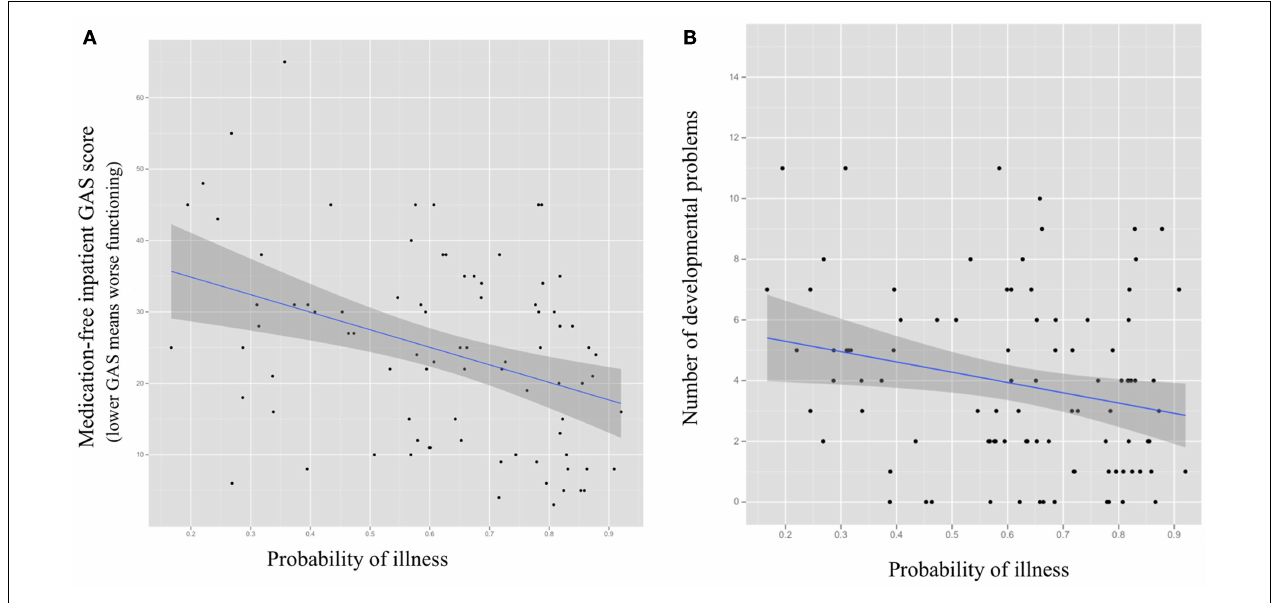
(GAS; p = 0.0004); (B) number of premorbid academic, language, social, and motor difficulties ( p = 0.02) with fitted regression line and 95% confidence